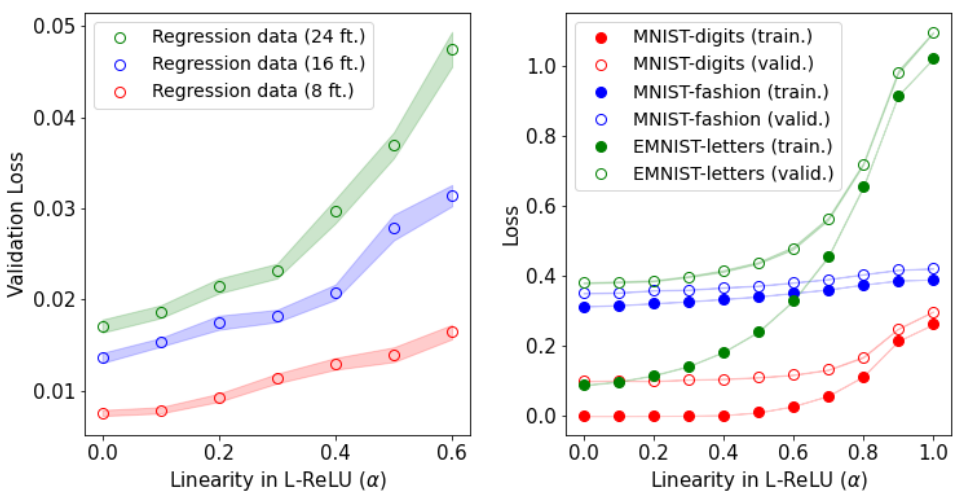
Figure 3. ( left panel ) Validation loss as a function of linearity factor ( α ) for continuous data with different dimensions: 8, 16 and 24 features (ft.). ( right panel ) Training and validation loss as a function of linearity factor ( α ) for categorical data (MNIST-digits, MNIST-fashion and EMNIST-letters data sets). Note that, to test the effects of data domains, a neural network with a fixed architecture shape was used in the modeling of all data sets shown in this figure. (see Appendix A.4, Tables A2 and A3) for model